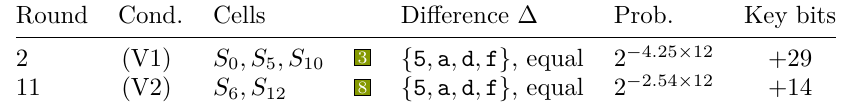
Table 2: Conditions used for key recovery and their probabilities (for all 12 valid pairs).